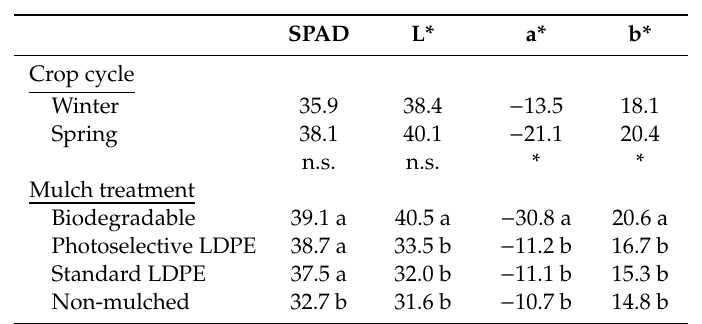
Table 2. Mean values of SPAD index and color components of perennial wall rocket as a ff ected by crop cycle and mulch